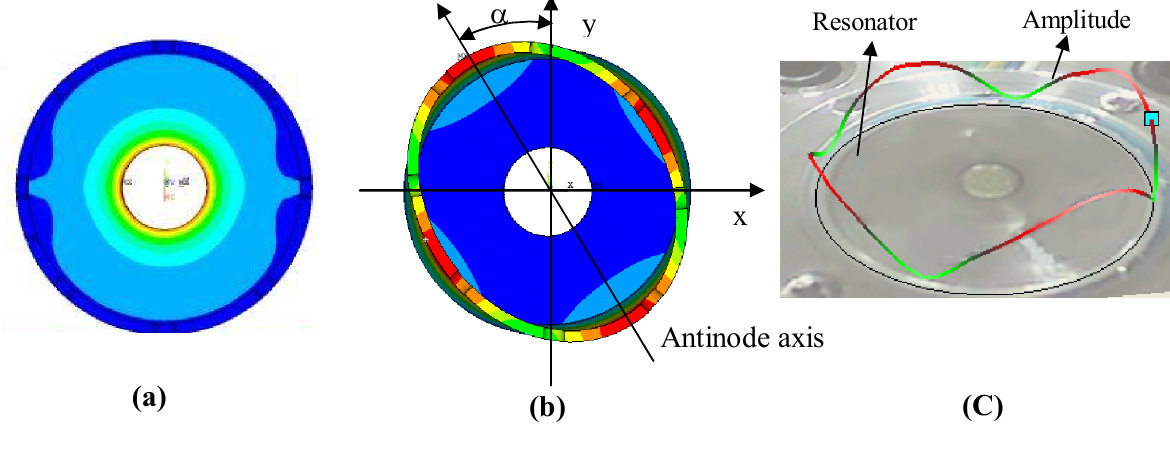
Figure 6. (a) Thermal stress contour of the cylinder resonator. (b) Simulation mode shape. (C) Experimental modal shape.